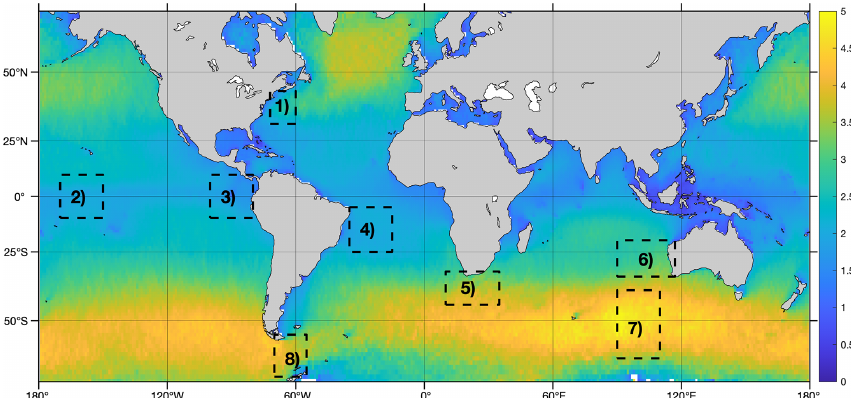
Figure 7. Yearly averaged SWH (m) computed over 2016–2018 from the Climate Change Initiative L4 products. Dashed black boxes define the eight areas analyzed in the section.